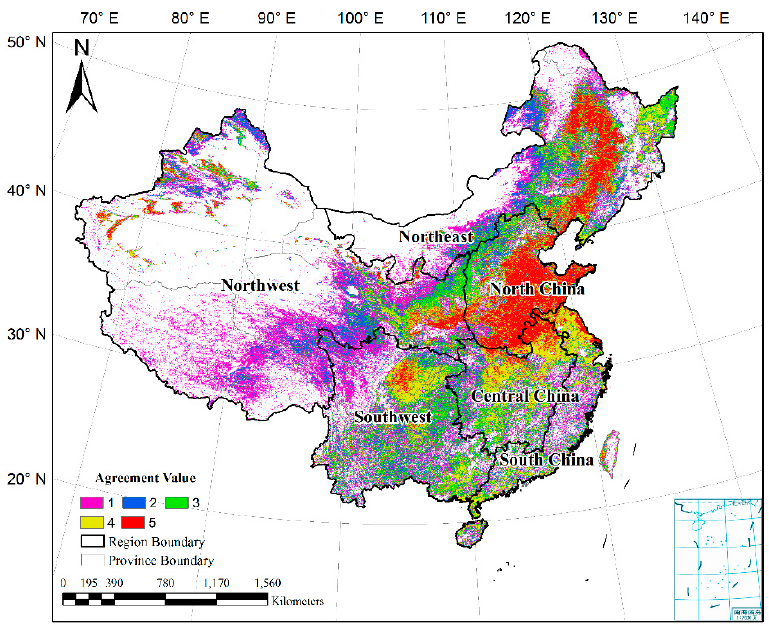
Figure 3. Spatial agreement of the five input datasets in the six regions of China.